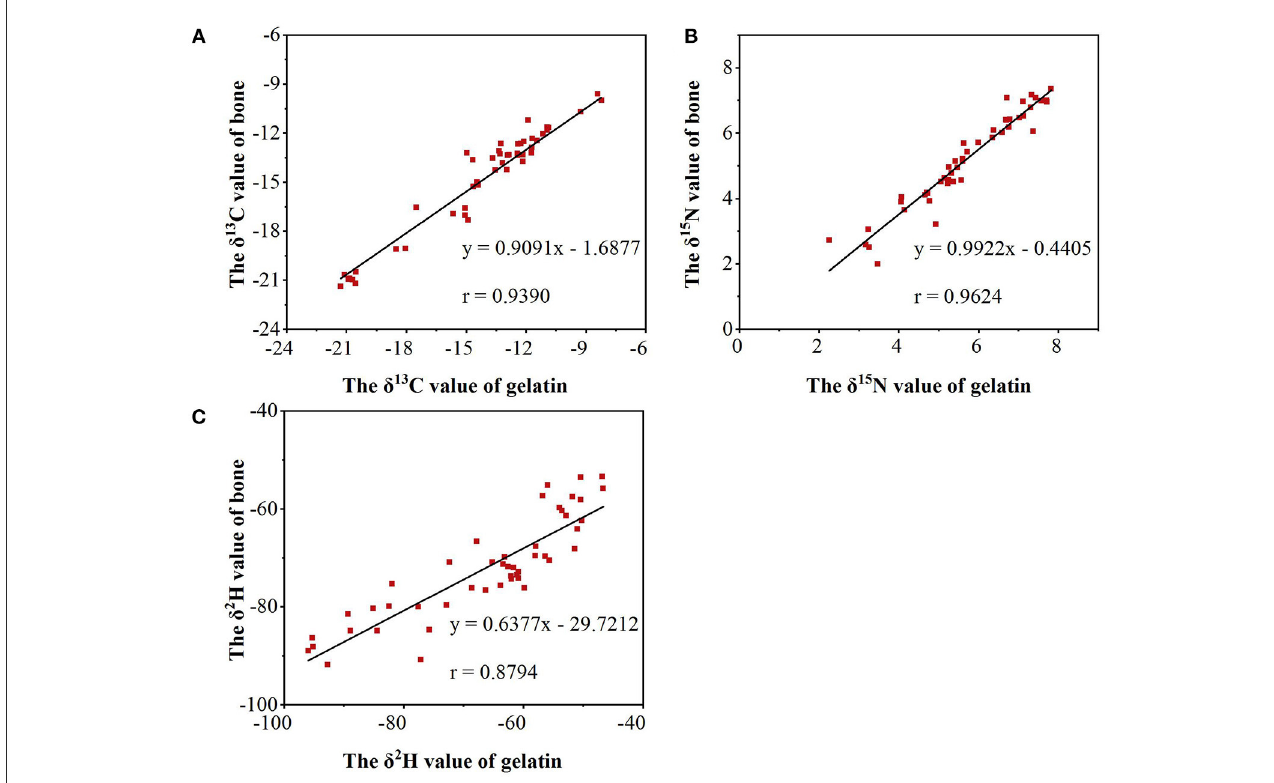
FIGURE5 The correlation coefficients of δ 13 C (A) , δ 15 N (B) , and δ 2 H (C) values between the gelatin samples and bone raw